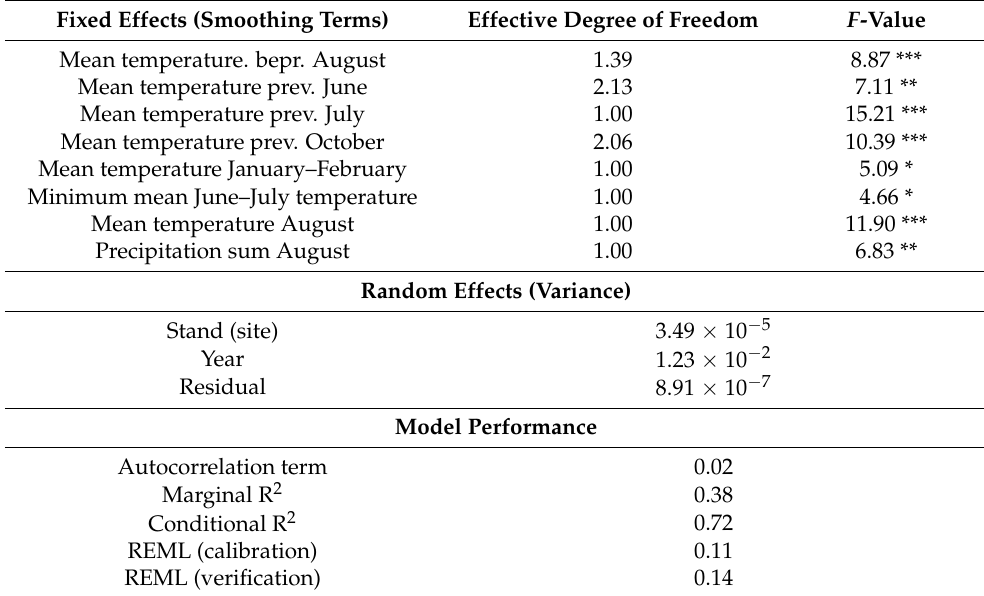
Table 4. Statistics of the regional generalization of responses of height increment of Scots pine from conventionally managed stands to meteorological conditions. For the fixed effects (meteorological variables), the effective degrees of freedom indicating the shape of the responses, their strength ( F -value) and significance ( p -value) are shown; for the random effects, estimated variance is shown. The overall performance of the model is described by marginal and conditional R 2 , as well as root mean square errors (REML) during calibration and cross verification. Significance codes; p -values: * < 0.05, ** < 0.01, *** < 0.001. Prev.—previous year, bepr.—before previous